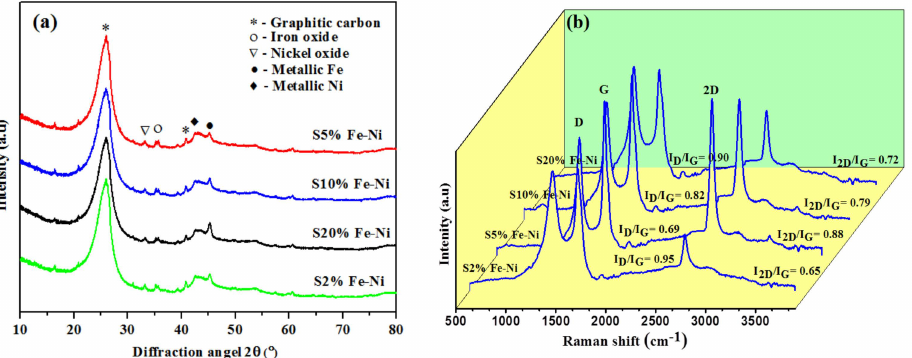
Figure 1. Results of: ( a ) XRD patterns and ( b ) Raman spectra for the different percentages of the double catalyst